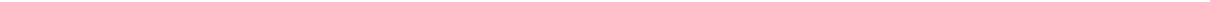
Figure 8 | Siah2 antagonizes drebrin function. ( a ) CGNs in culture expressed Emerald MAPT and RFP LIFEACT to label the microtubule and actin cytoskeleton. Time-lapse imaging shows that Siah2-insensitive drebrin NxN rescues a Siah2 gain-of-function phenotype. Top row: Control CGNs have long neurites. Middle row: Siah2 gain of function inhibits CGN neurite extension, induces a radial microtubule cytoskeleton and locks CGNs in a mesenchymal morphology. Bottom row: CGNs expressing drebrin NxN and Siah2 have neurites and microtubule cytoskeleton similar to controls. Scale bar, 10 m